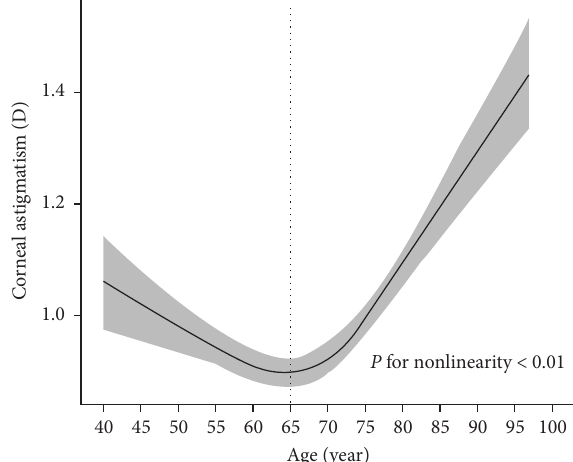
Figure 3: Association between corneal astigmatism and age. Corneal astigmatism is indicated by a solid line, and 95% confi- dence interval is indicated by the shaded